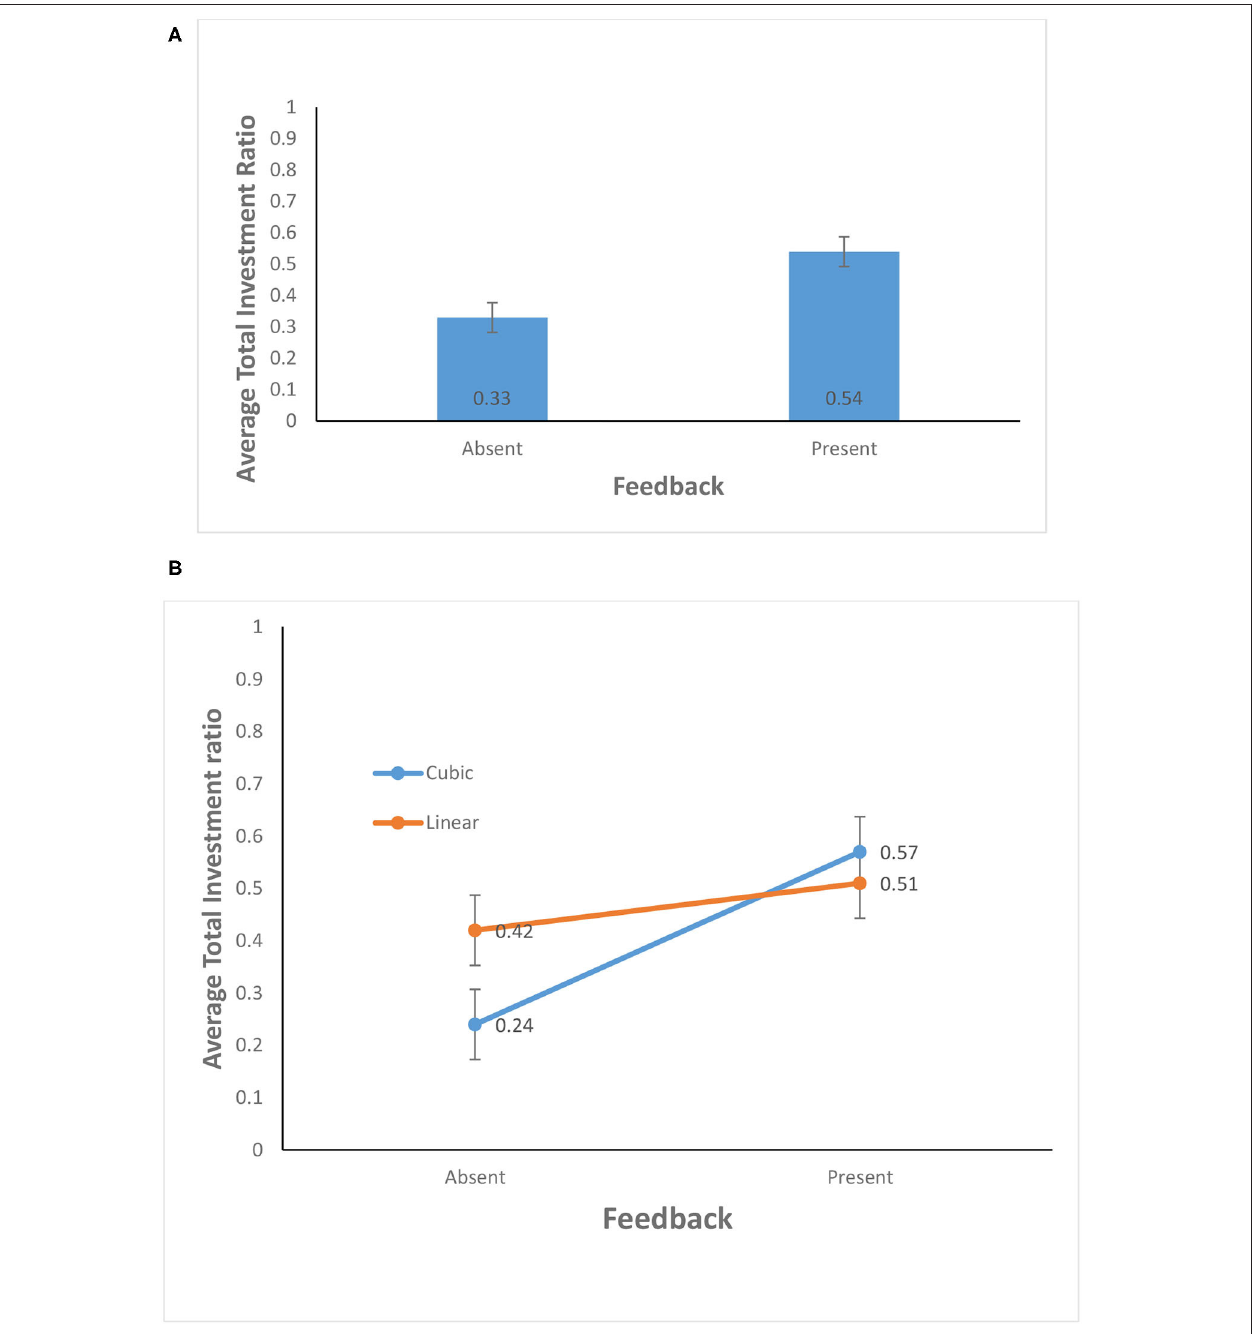
FIGURE 4 | (A) Average total investment ratio in feedback-present and absent conditions. (B) Average total investment ratio in cubic and linear probability of climate change and feedback-present or absent conditions. The error bars show 95% CI around the point estimate.